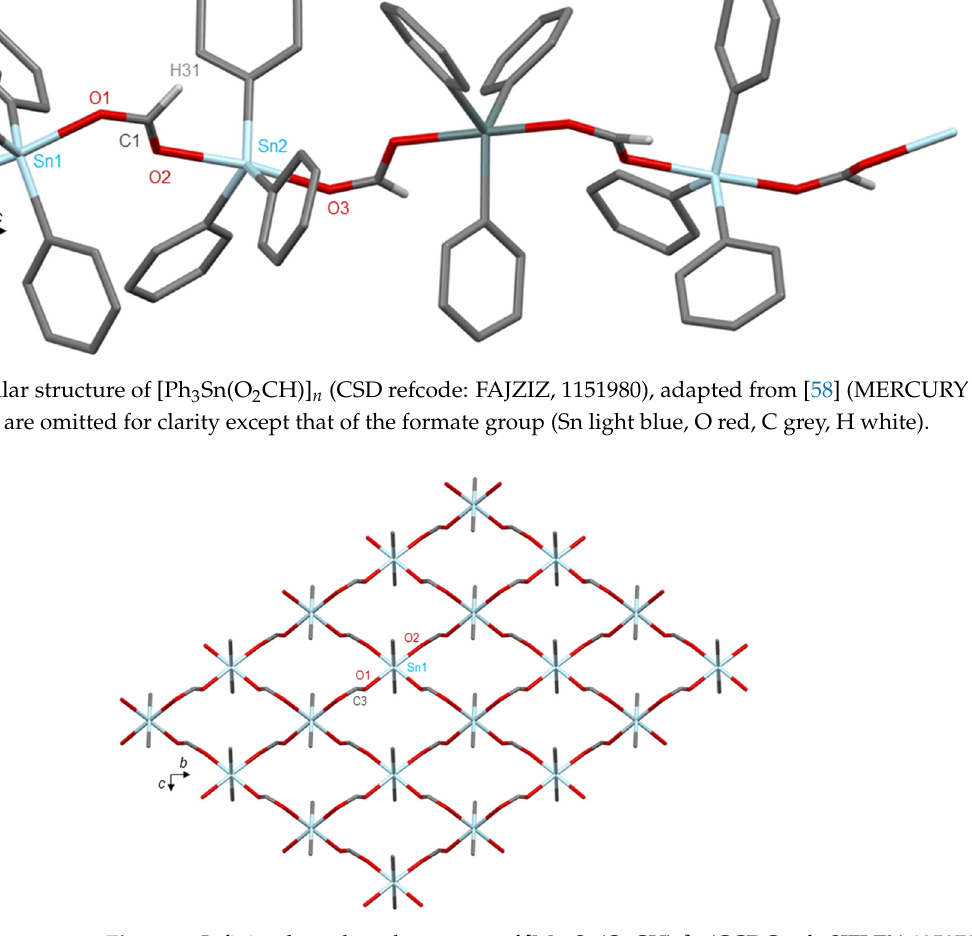
Figure 8. Polymeric structure of [ n -Bu 2 Sn(O 2 CH) 2 ] n (CCDC ref.: EKONEY, 783726), adapted from [60] (MERCURY view). Hydrogen atoms are omitted for clarity and for each n -butyl chain; only the α -carbon atoms bonded to tin are shown (Sn light blue, O red, C grey).